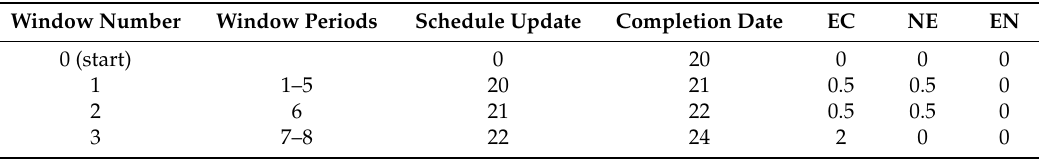
Table 1. The results of window analysis method.